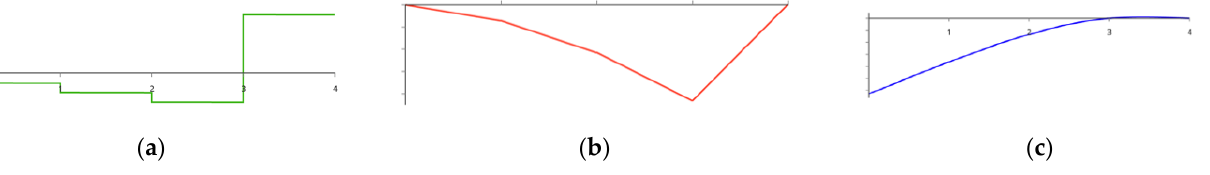
Figure A13. Cantilever beam ( a ) shear force diagram, ( b ) bending moment diagram, and ( c ) deflection diagram over the beam length in m. The beam can be analytically solved with the equations shown in Table A5.